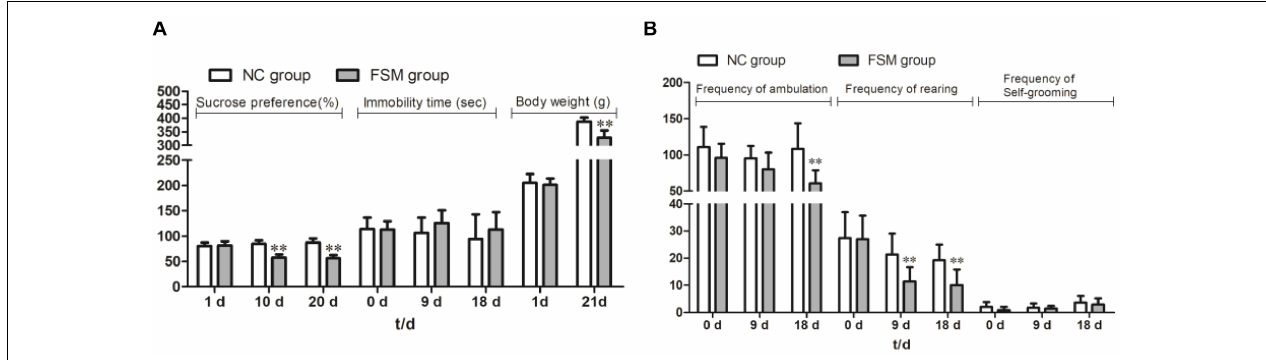
FIGURE 2 | Behavioral assessment of pregnant rats. The pregnant rats’ results for (A) the Sucrose Preference Test, immobility time, and body weight changes and (B) the Open Field Test are presented. Values are expressed as means ± standard deviations. NC group, normal control group ( n = 10); FSM group, fear stress model group ( n = 12). ** P < 0.01 versus the NC